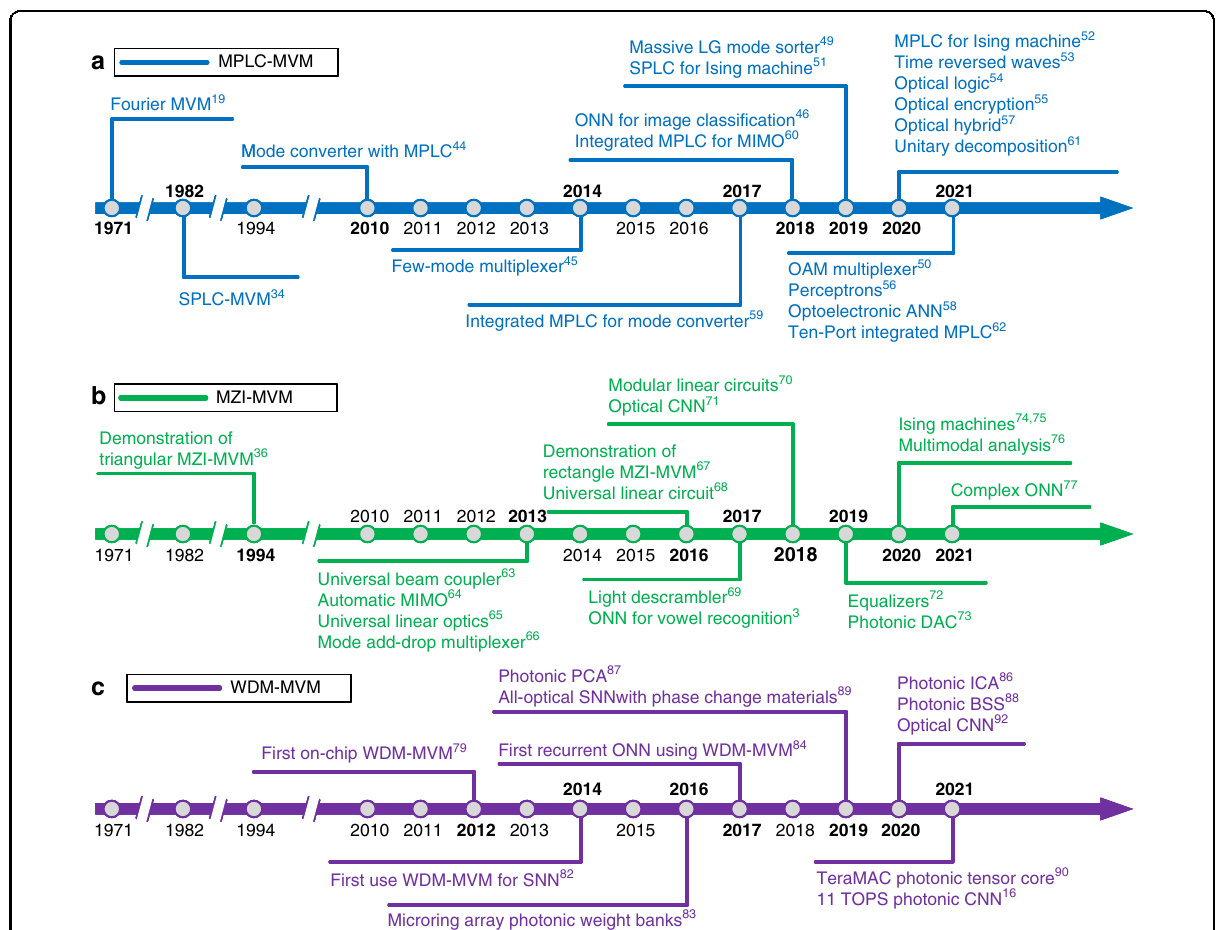
Fig. 2 Timeline of advances in photonic matrix computations and neuromorphic photonics. a MPLC-MVM. b MZI-MVM. c